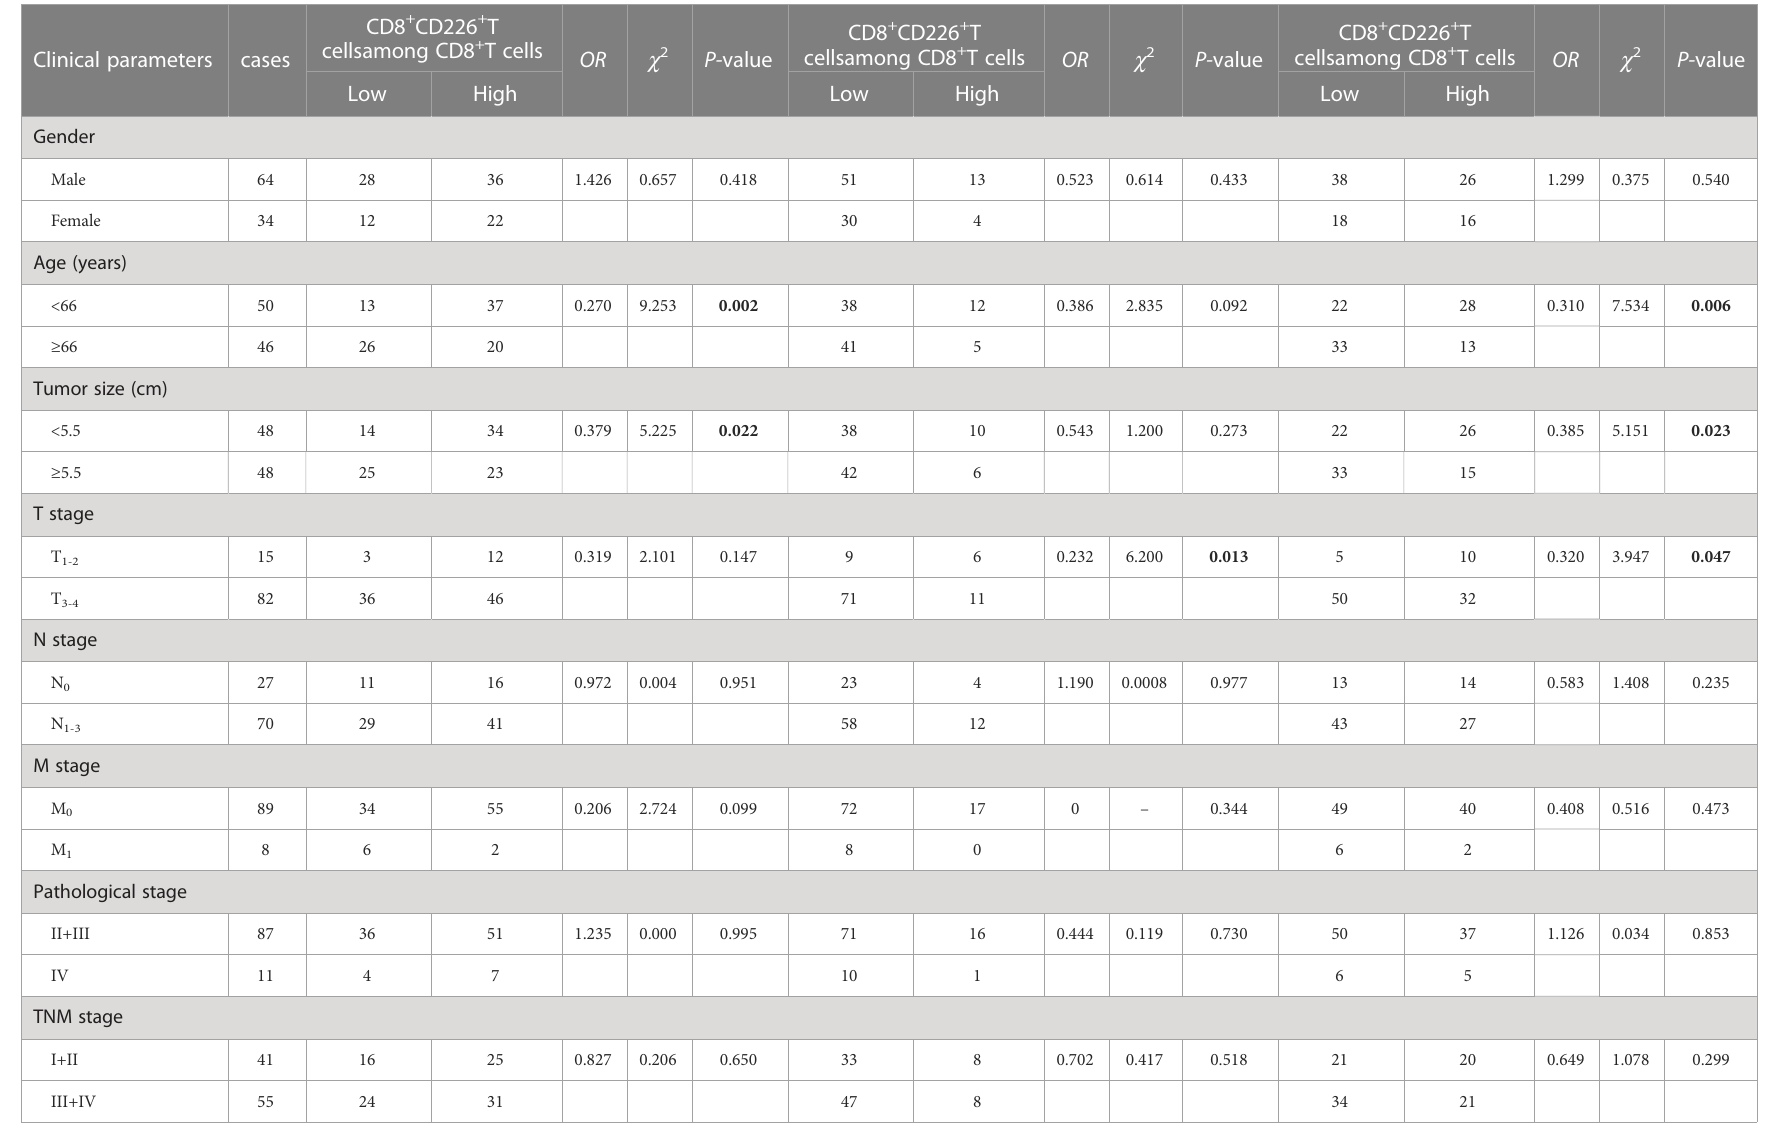
TABLE 4 The association between the percentages of CD8 + CD226 + T cells/CD8 + T cells, CD8 + CD226 + T cells/CD8 + T cells in the epithelial cell region, and CD8 + CD226 + T cells/CD8 + T cells in the stromal cell region in tumor and clinical features of GC